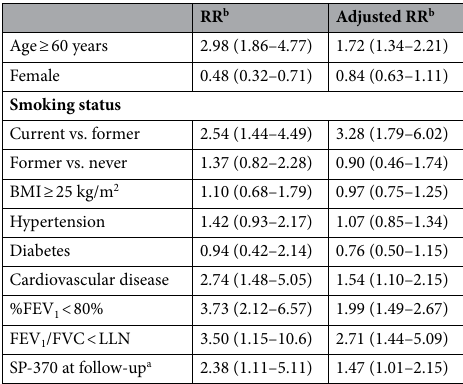
Table 4. Risks associated with the development of AFL with dyspnoea at 5 years. RR risk ratio, AFL airflow limitation, BMI body mass index, FEV1 forced expiratory volume in 1 s, FVC forced vital capacity, LLN lower limits of normal. a Spirometer used at follow-up. b RR (95% confidence